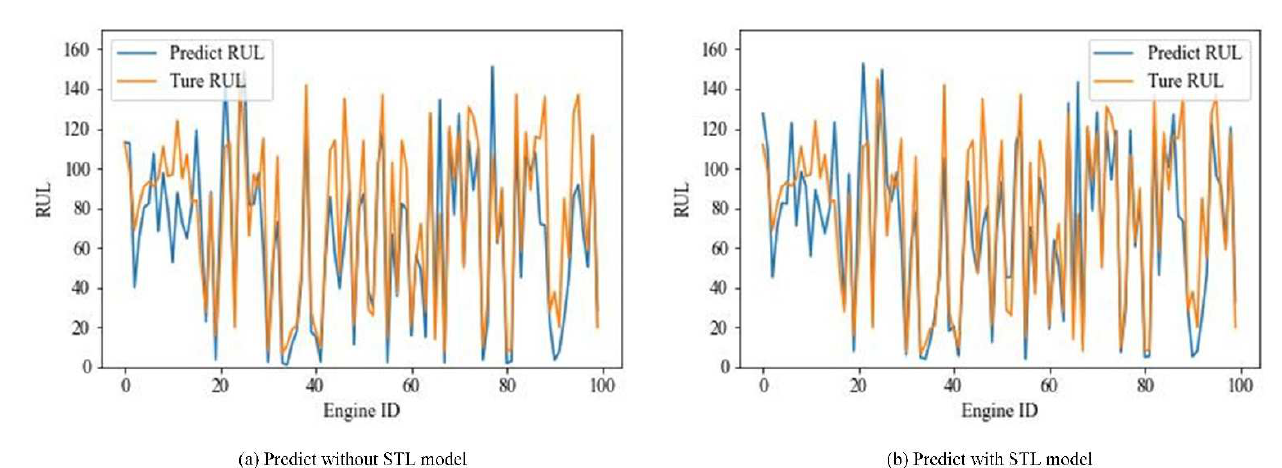
Figure 15. RUL prediction results of each engine.